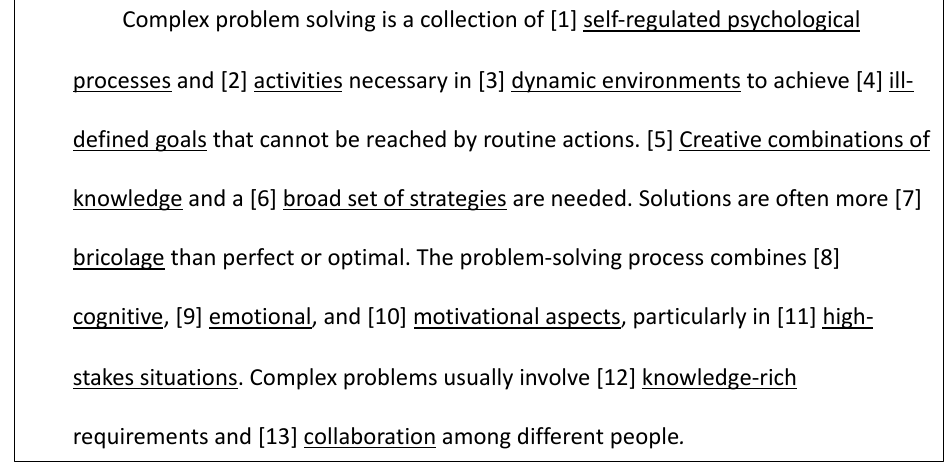
Figure 2. Excerpt from Dörner and Funke (2017, p. 6) showing distinct components (our enumeration and underlining) likely to define a composite-formative variable in the Bollen and Diamantopoulos (2017) framework.